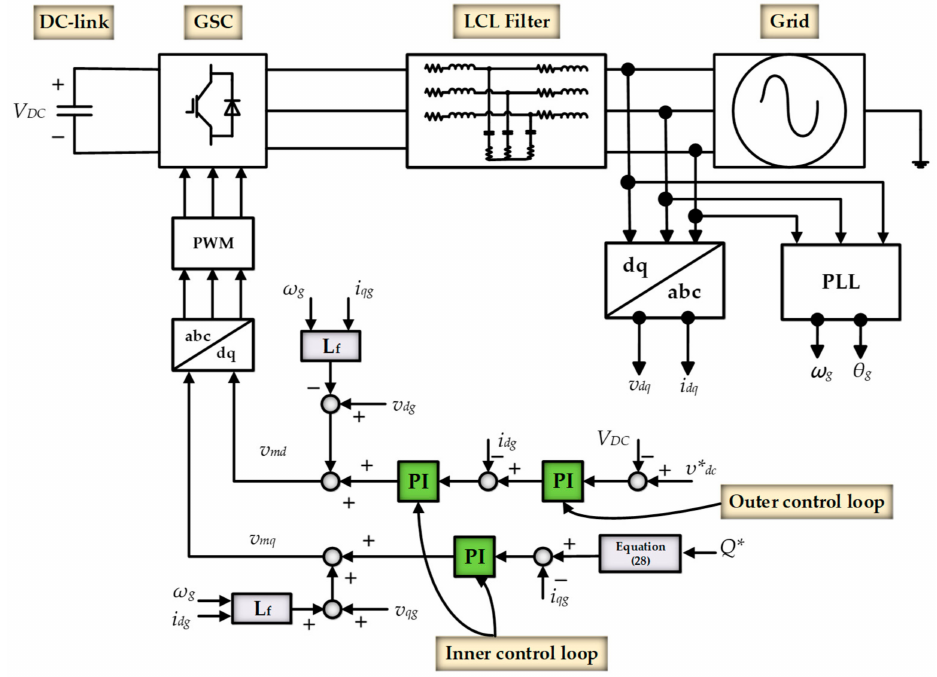
Figure 10. Voltage-oriented control of the